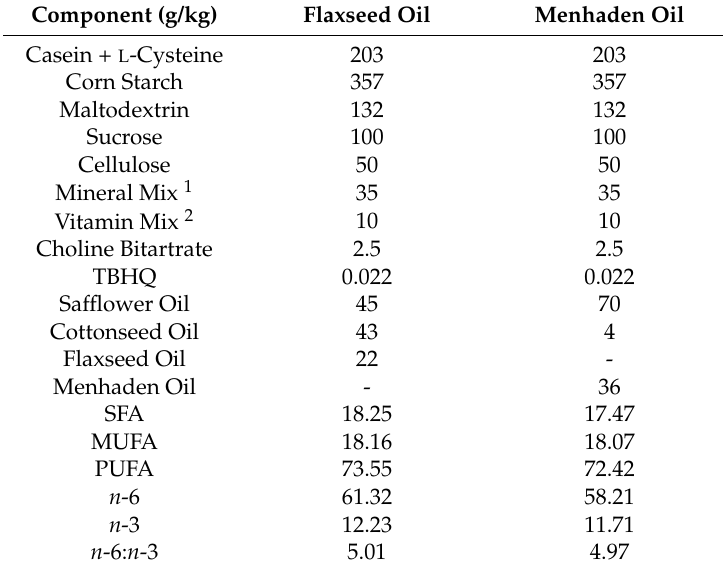
Table 1. Components of intervention diets. Component (g/kg) Flaxseed